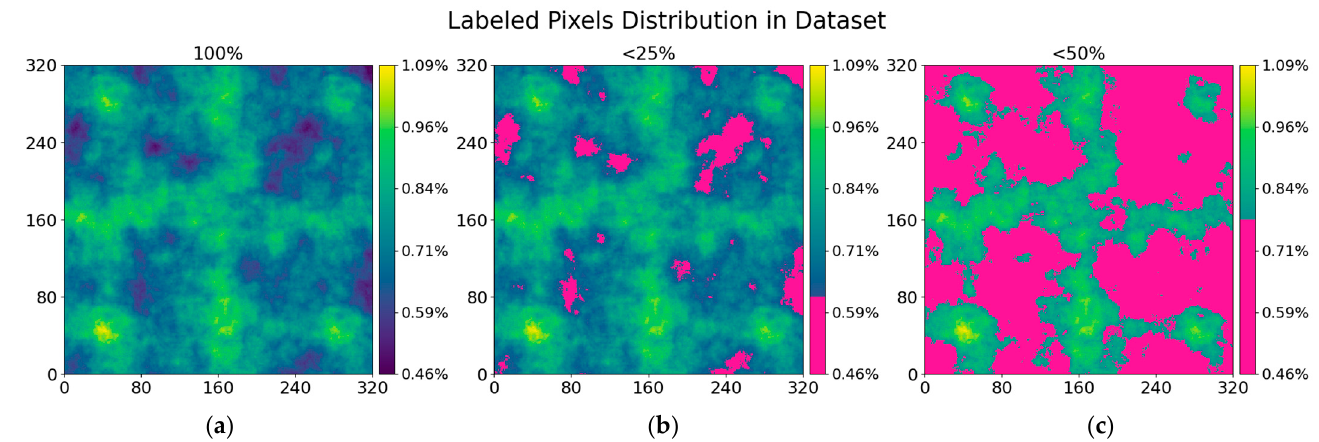
Figure 10. Individual pixels overlap by the label in the augmented dataset. ( a ) Full coverage of individual pixel covered by hole label pixel. ( b , c ) Areas where pixels are covered less: b < 25%, c < 50% in comparison with the maximum covered area (1.09% of data samples).